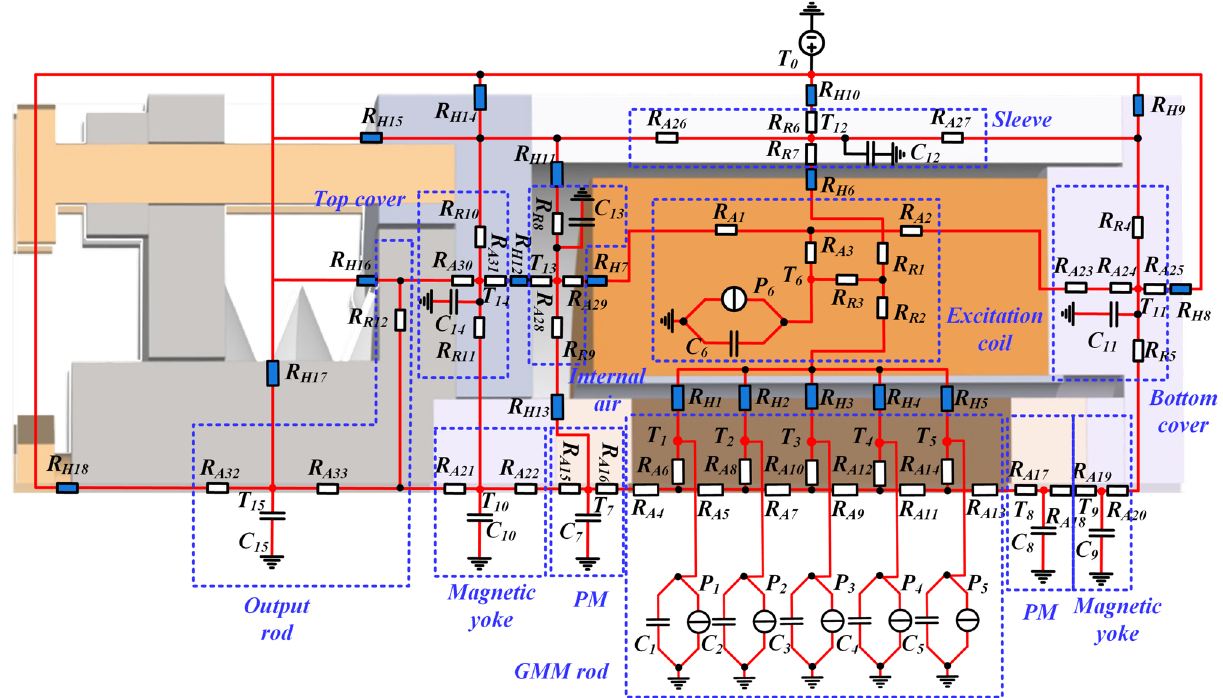
Figure 7. Equivalent thermal network model of the longitudinal vibration GMT.